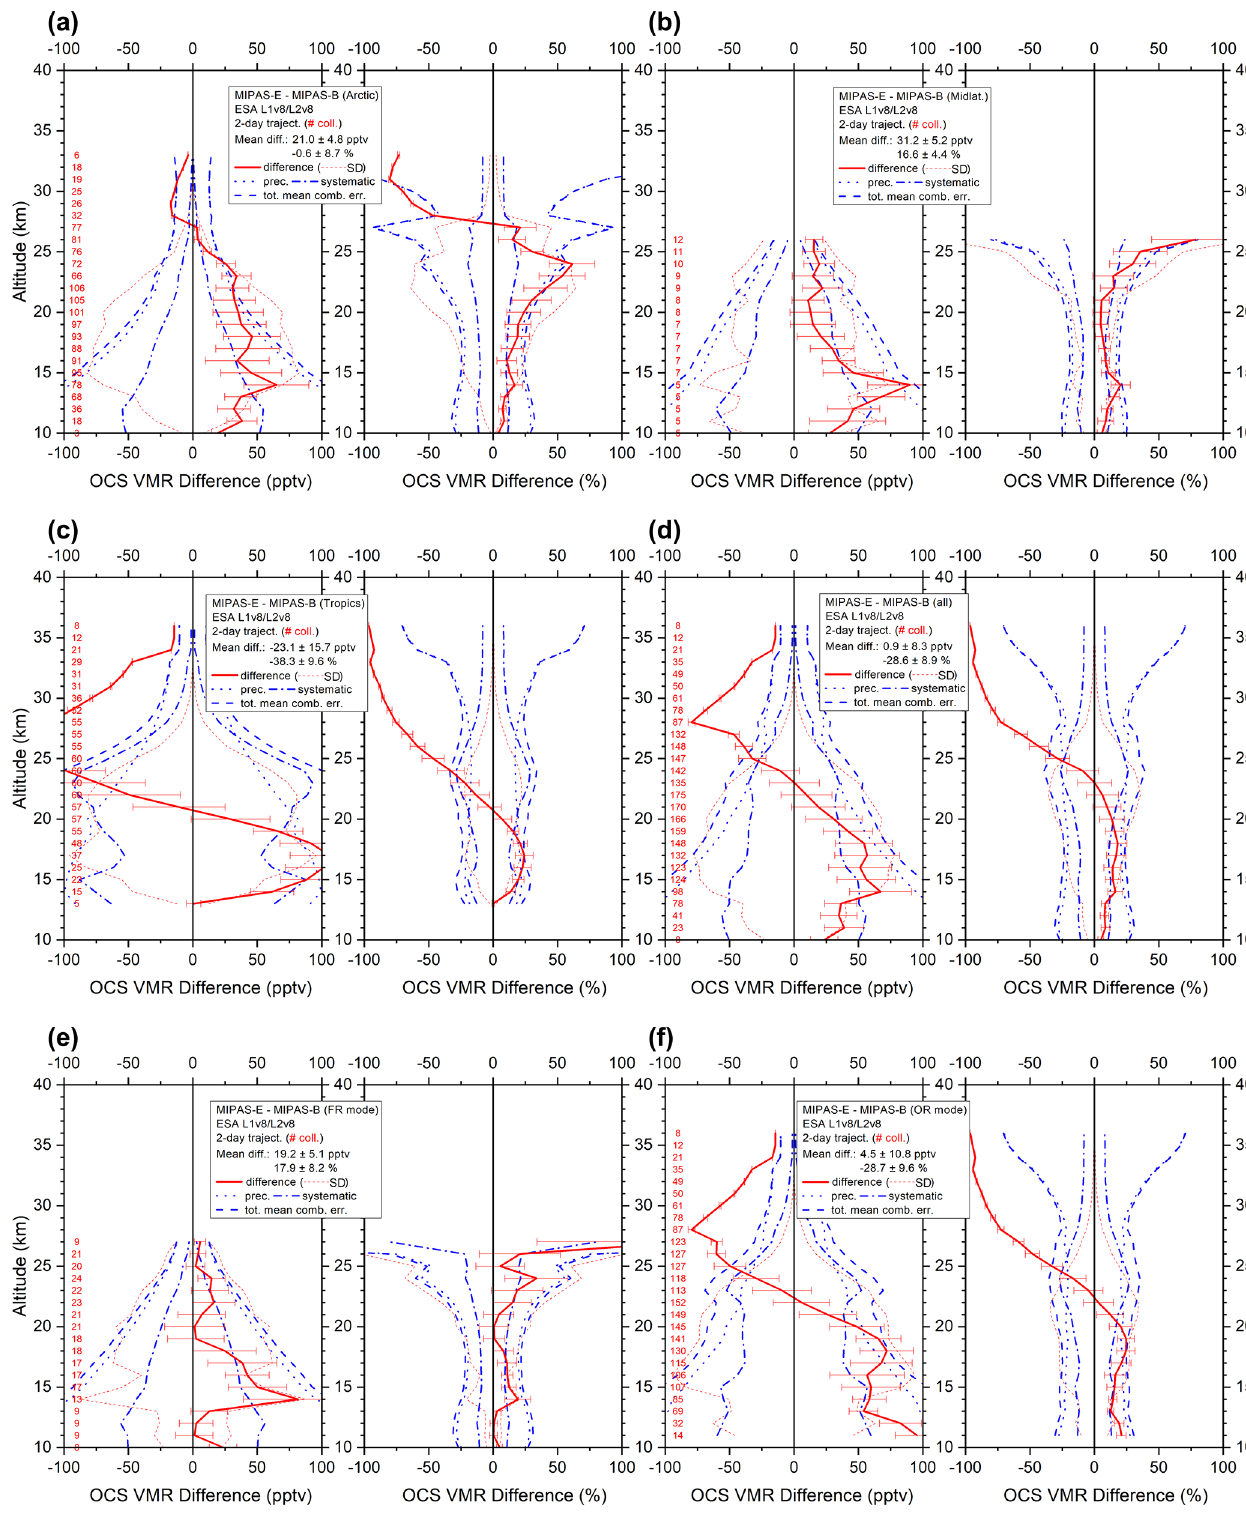
Figure 21. Same as Fig. 3 but for